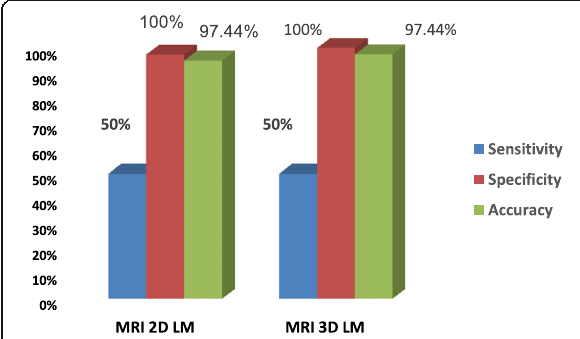
Fig. 8 Comparison of sensitivity, specificity, and accuracy between 2D VS 3D in detecting LM tears